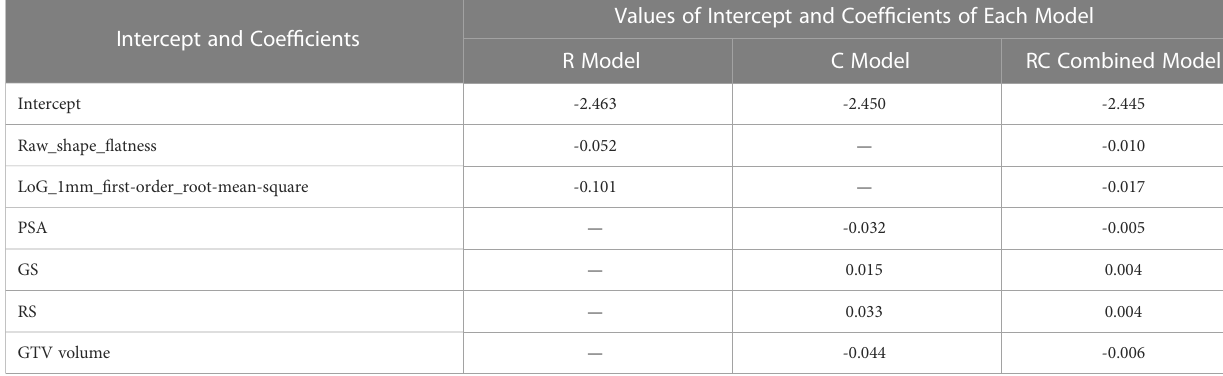
TABLE 2 Intercepts and selected radiomic and/or clinical features of the R, C and RC combined models.